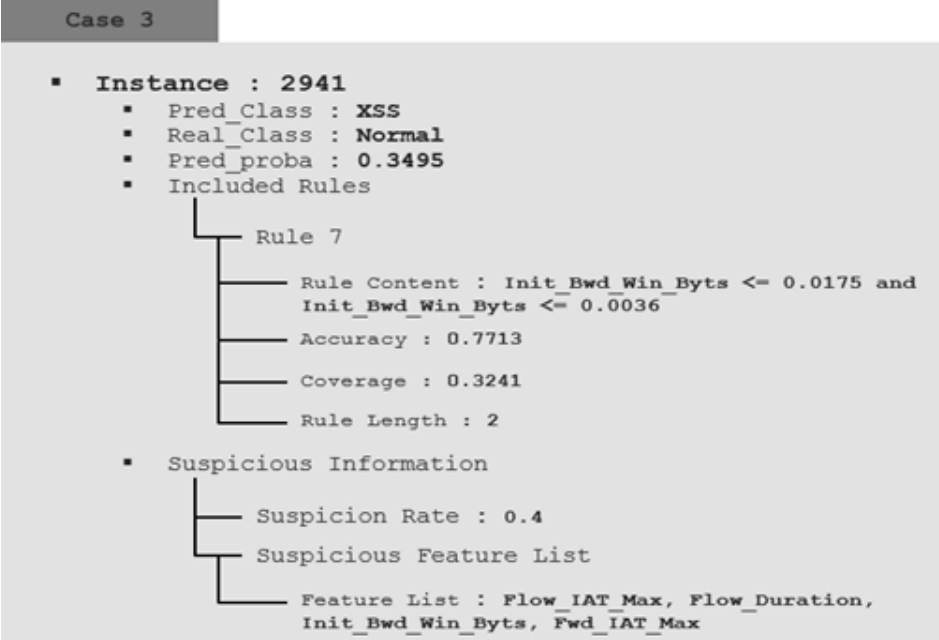
Figure 7. Proposed method-based system validation.